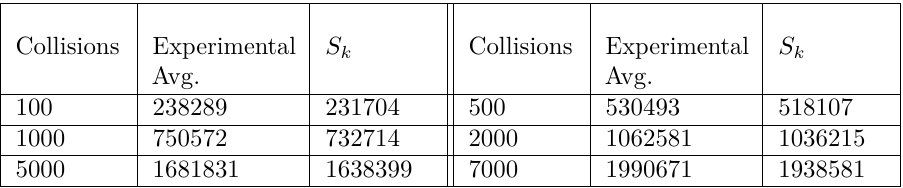
Table 1: Comparing the asymptotic value of S m to an experimental average. Collisions